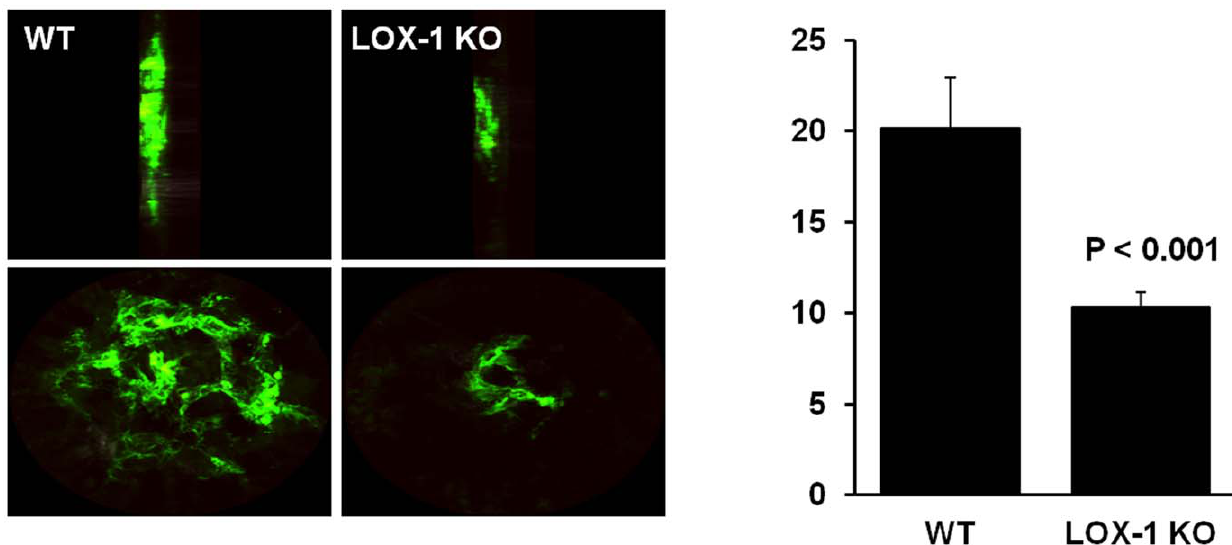
Figure 3. Effects of LOX-1 abrogation on choroid angiogenesis. Eyes of 8 week old wild type (C57BL) and LOX-1 KO (C57BL background) mice were subjected to laser photocoagulation (see Materials and Methods). Choroid angiogenesis was visualized in RPE-choroid-sclera flat mounts from animals perfused with 1 ml of PBS containing 50 mg/ml FITC-dextran after 7 days. Mounts were examined under a ZEISS LSM 510 laser confocal microscope and images of laser spots were captured. The images represent 3D reconstruction of the choroid neovascularization complex.